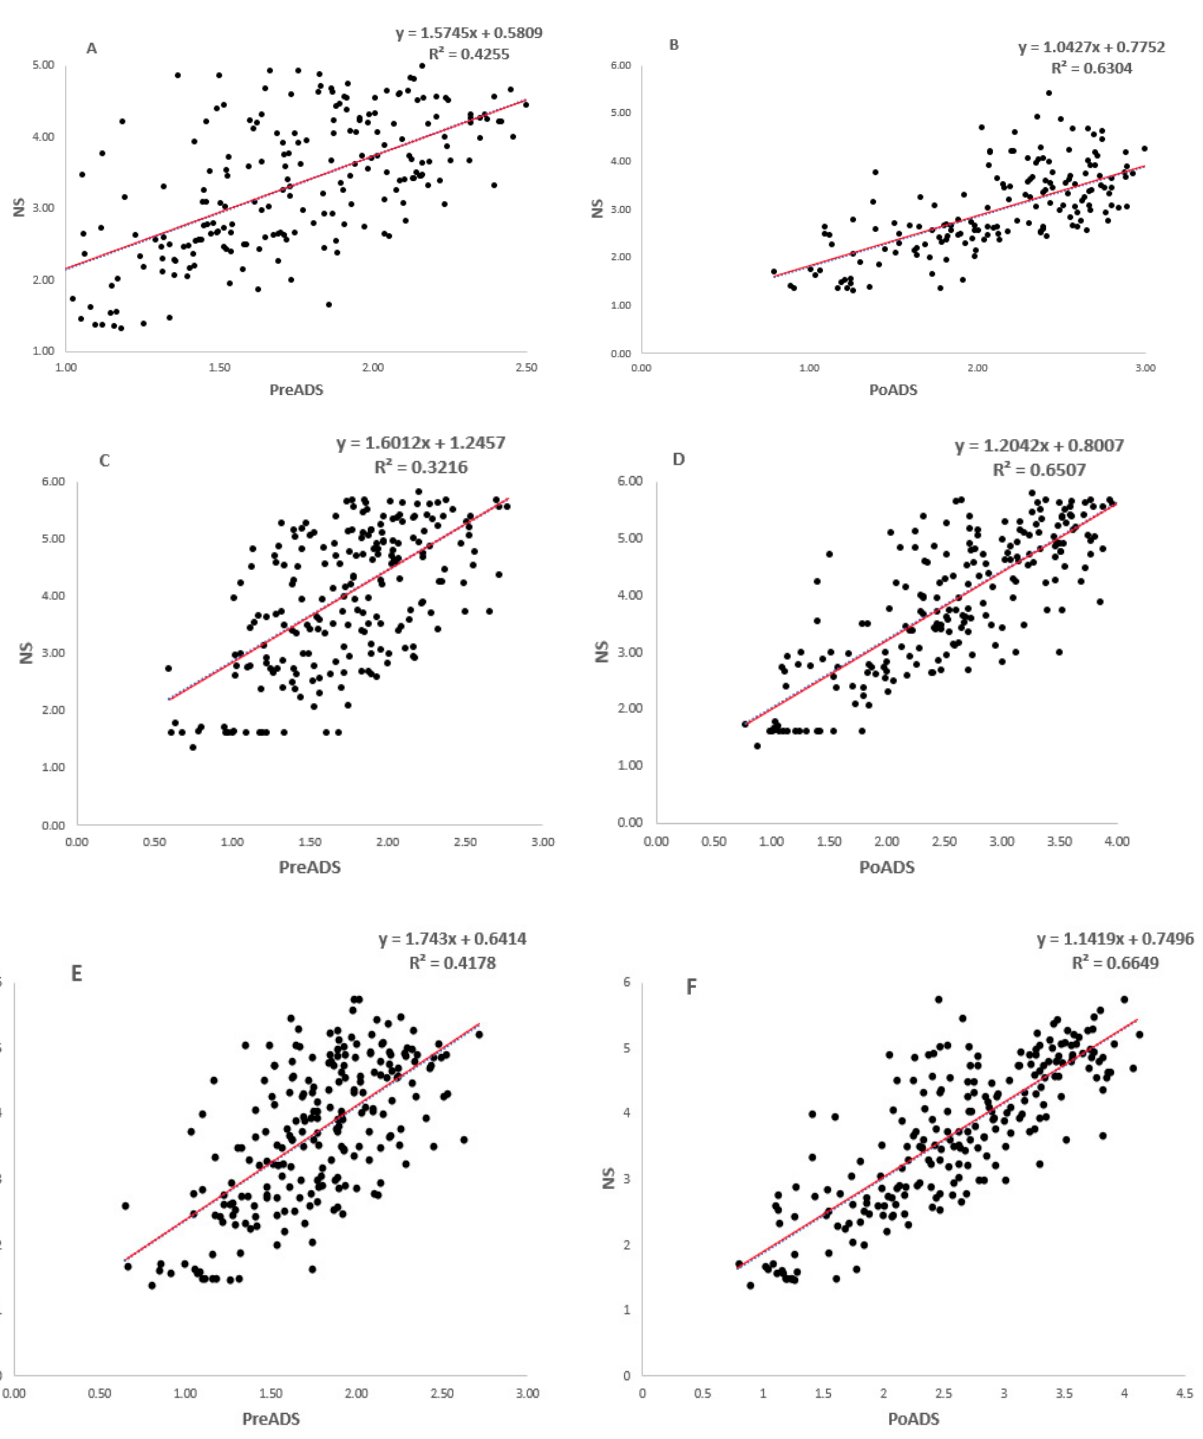
Figure 1. Scheme showing grouping of 225 sorghum genotypes for mean grain yield (t/ha) when evaluated under non-stressed (NS), pre-anthesis drought-stress (PreADS), and post-anthesis drought-stress (PoADS) conditions in the greenhouse ( A , B ) and field ( C , D ) environments, and across both glasshouse and field ( E , F ) environments. The box plots summarise the five data sum- maries (minimum, first quartile, median, third quartile, and maximum) of grain yields under NS, PreADs, and PoADS conditions.